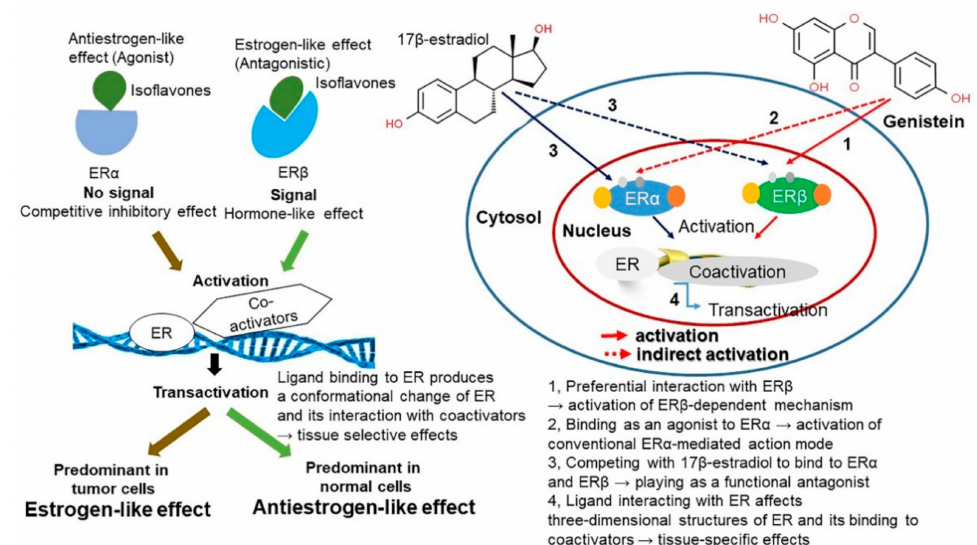
Figure 4. Phytoestrogenic activity of soybean isoflavone mediated by estrogen receptor beta (ER β ) [51], predicted action mode of 17 β -estradiol, and potential interaction of isoflavones in hu- mans [52]. If isoflavones (genistein) with activity similar to that of 17 β -estradiol bind to ER β , it will promote a signal with an estrogen-like effect (antagonist), leading to the development and differenti- ation of normal cells by upregulating ER and coactivators. In contrast, isoflavones binding to ER α act as a predominant effector with an estrogen-like effect (agonist) in tumor cells. Figure adapted from Huser et al.